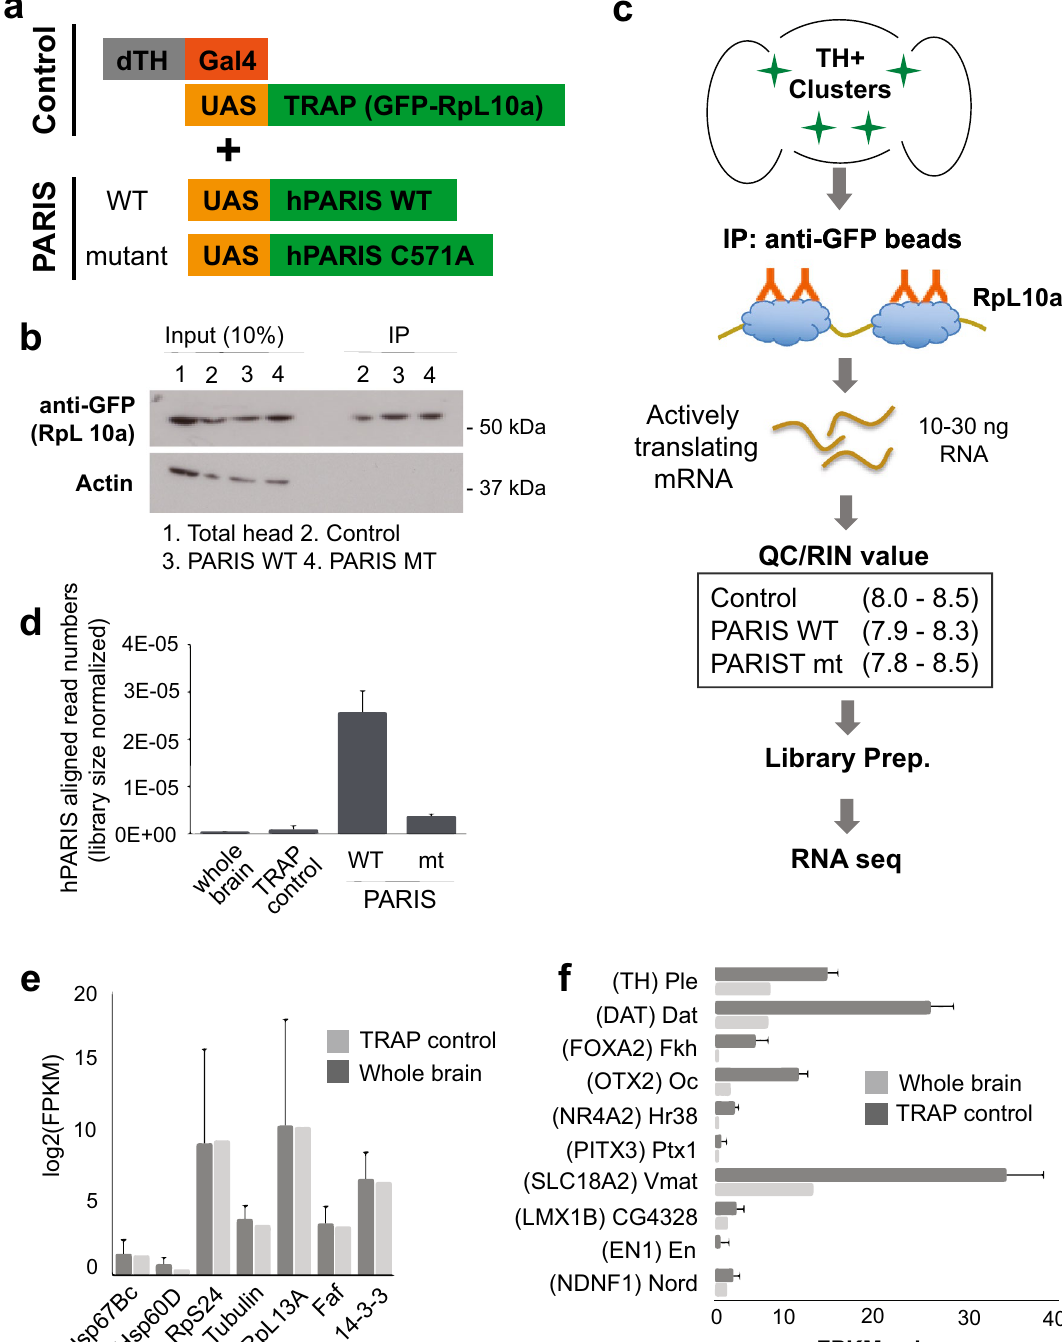
Figure 1 . TRAP enables cell type–specific isolation of RNA from dopamine neurons. ( a ) The customized approach here for isolating RNA from dopamine (DA) neurons in Drosophila is based on use of human PARIS (hPARIS) expression construct to induce PD phenotype in fly and GFP-tagged ribosomal protein L10a (GFP-L10a) to specifically target actively translating mRNAs. ( b ) Immunoblotting results showing the expression of GFP-L10a fusion protein only for a qualitative assessment. The original membranes were cut prior to hybridization with antibodies during blotting. ( c ) TRAP-seq protocol. RNA integrity numbers (RINs) of around 8 or more demonstrating a high RNA integrity before sequencing. ( d ) Library size-normalized read counts calculated for hPARIS gene in fly genome, with PARIS wild type taking the lead as expected. ( e ) FPKM- normalized expression levels of a randomly selected group of fly housekeeping genes demonstrating TRAP protocol did not cause a global change in the transcriptome. ( f ) FPKM-normalized expression levels of DA neuron-specific biomarker genes significantly enriched in TRAP control. All RNA-seq based expression data presented here were expressed as mean ± standard error of the mean (SEM) values, for each condition